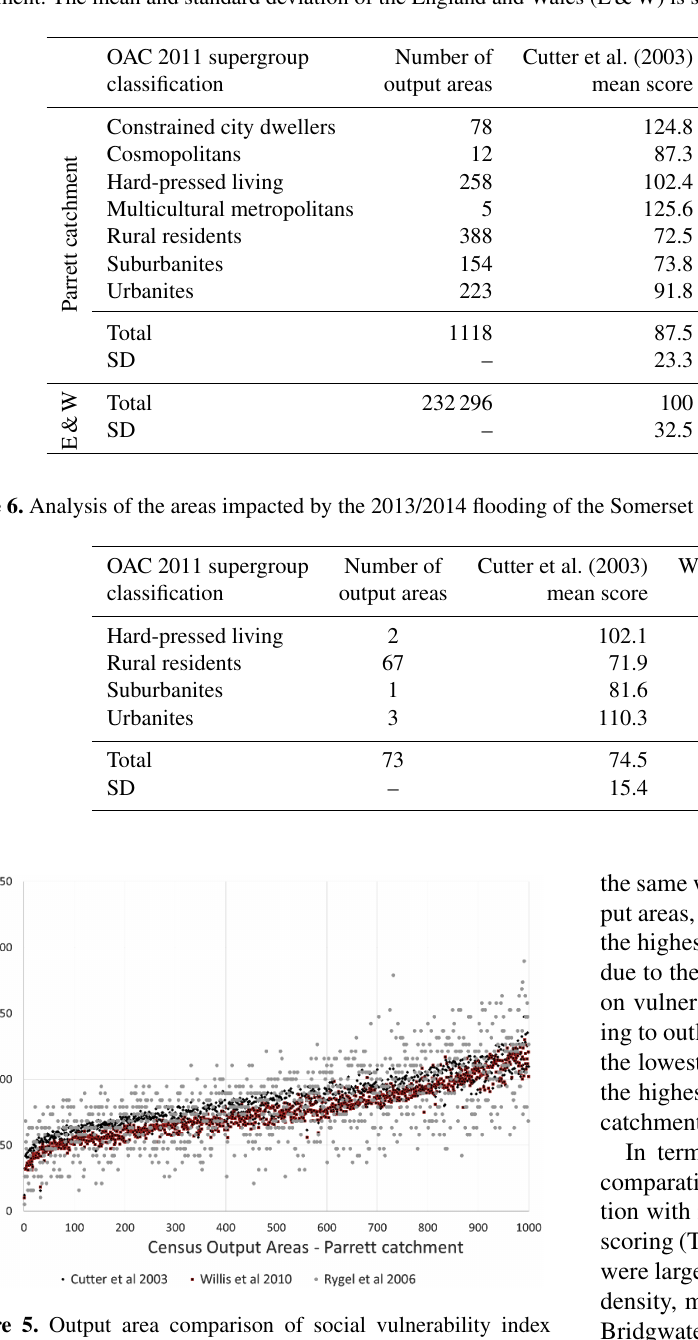
Table 5. Comparison of mean and standard deviations of the social vulnerability index scores by OAC 2011 classification within the Parrett catchment. The mean and standard deviation of the England and Wales (E&W) is shown for comparison.